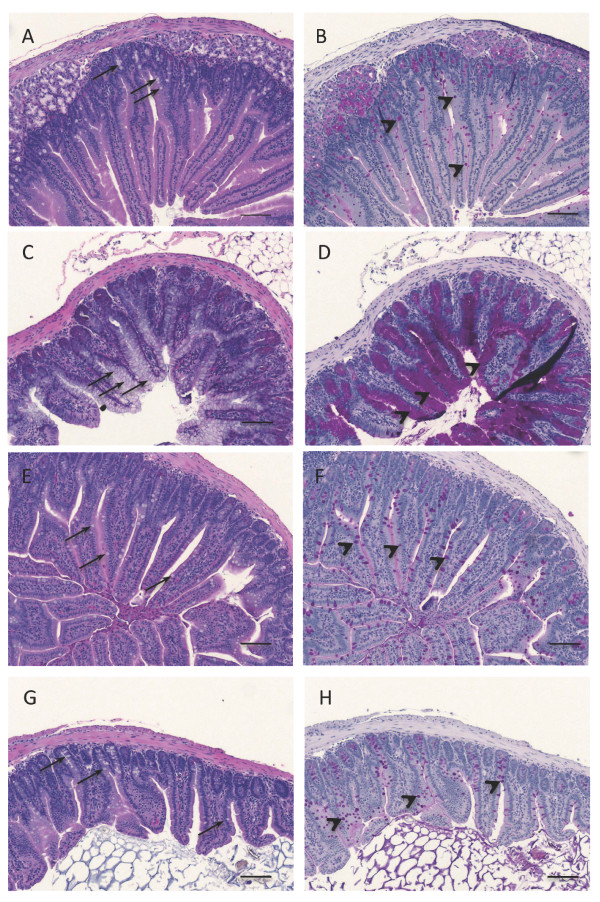
Photomicrographs of ileum sections (10X magnification) from mice treated seven days x b.i.d. with gamma-secretase inhibitors noted below. Selected sections represent the range of goblet cell hyperplasia observed in this study. In H&E stained sections (a, c, e and g), goblet cells appear as cells with clear or foamy cytoplasm (arrows) while in PAS stained sections (b, d, f and h) they appear as dark magenta stained cells (arrow heads). A normal population of goblet cells was observed in all vehicle control mice (a, b). All positive control LY411575 treated mice had a moderate increase in goblet cells (c, d). There was no apparent dose-related increase in goblet cells across ELN475516 treated groups (see Table 2); among all mice in these groups, 21 had no increase in goblet cells, 8 had a questionable increase (illustrated by a single animal from 100 mg/kg dose group g, h). A single mouse from the 600 mg/kg dose group had a mild increase in goblet cells, which is shown for comparison purposes in panels (e and f). Scale bar = 100 μm.